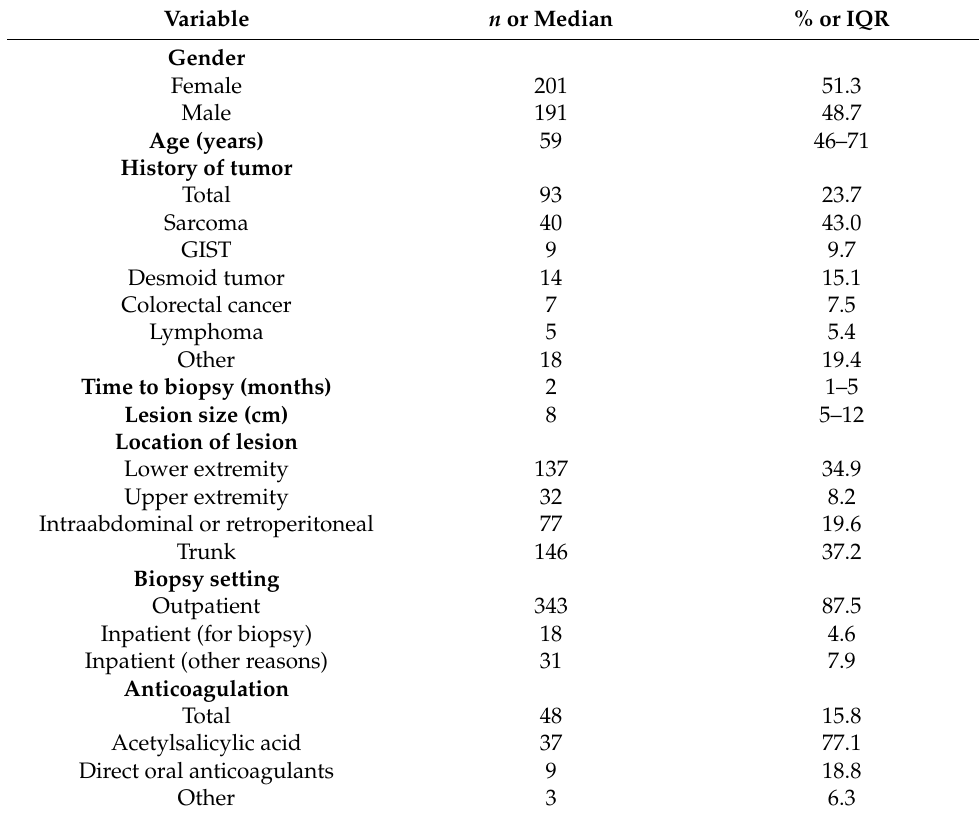
Table 1. Clinical characteristics of CNB